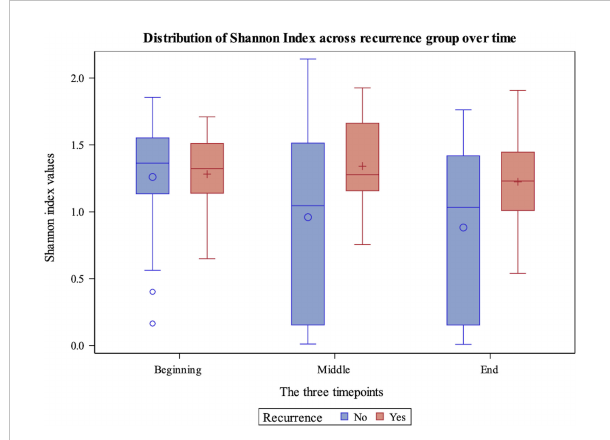
FIGURE 1 Box plot demonstrating Shannon Diversity Index measures for non- recurrence and recurrence patients within the cohort across beginning, middle and end timepoints. The y-axis displays the value of the Shannon Diversity Index. The x-axis indicates